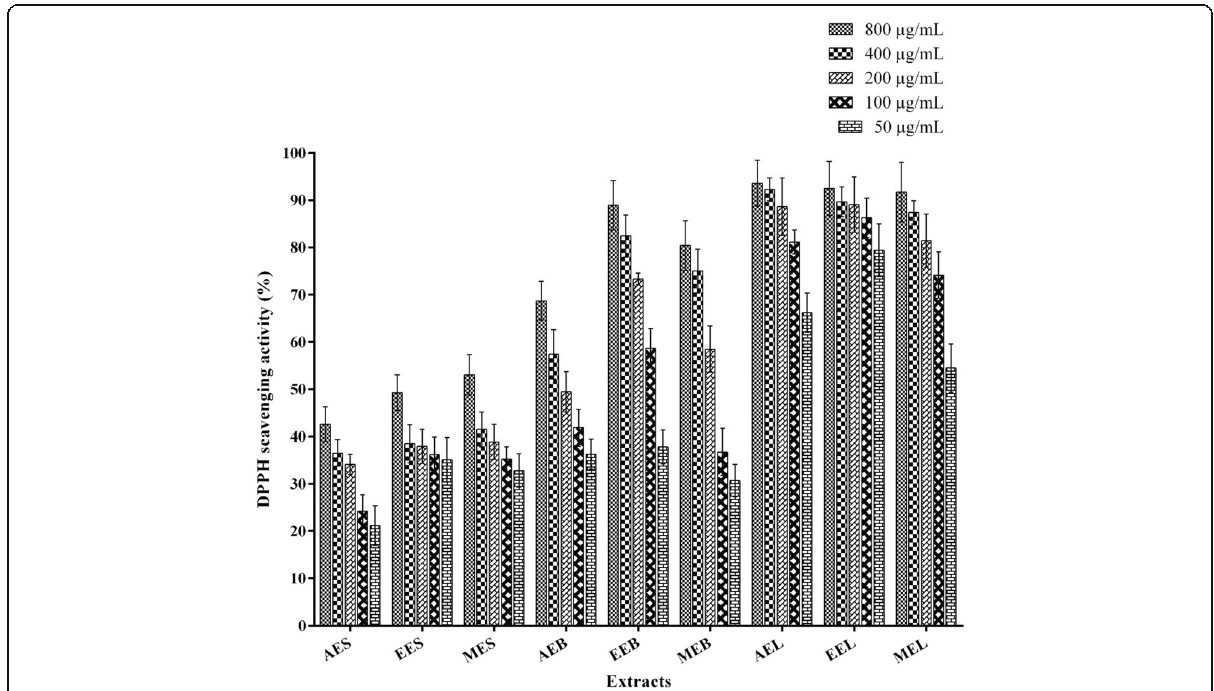
Fig. 4 DPPH scavenging activity by five different concentrations of B. orellana extracts . AES = aqueous extract (seed); EES = ethanolic extract (seed); MES = methanolic extract (seed); AEB = aqueous extract (branch); EEB = ethanolic extract (branch); MEB = methanolic extract (branch); AEL